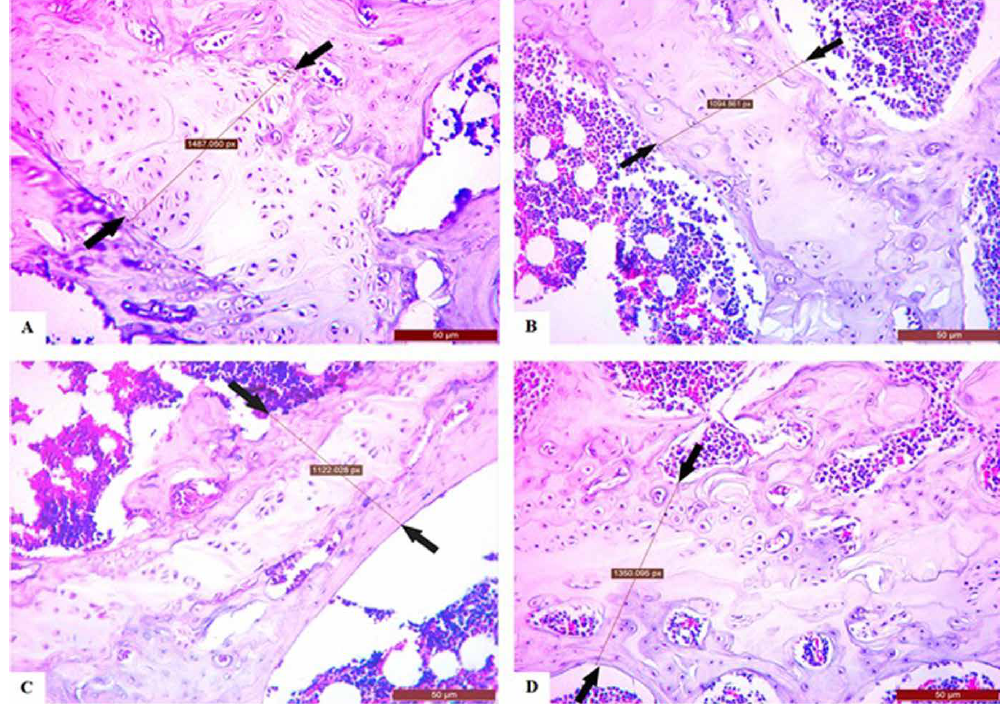
FIGURE 3 – Images showing the trabecular bone thickness of the right femur head in rats with ovariectomy-induced osteoporosis. A: Control group, B: OVX group, C: OVX+zaprinast group and D: OVX+avanafil group. The plain range or channels indicate mineral deposits. Scale bar: 100